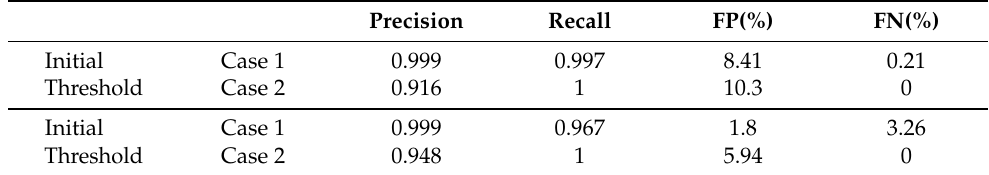
Table 1. Experimental